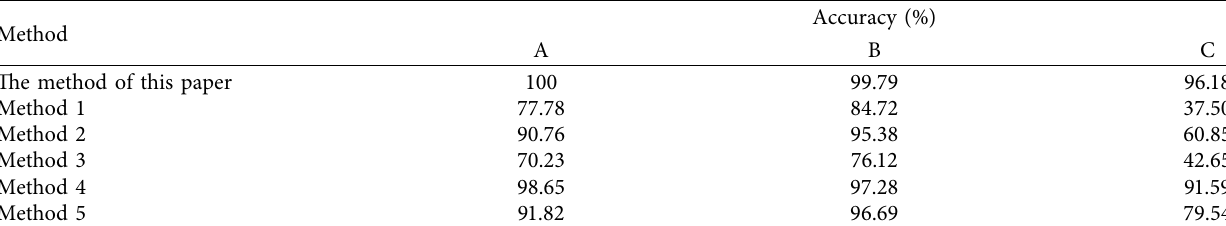
Table 8: Diagnostic accuracy of different methods.